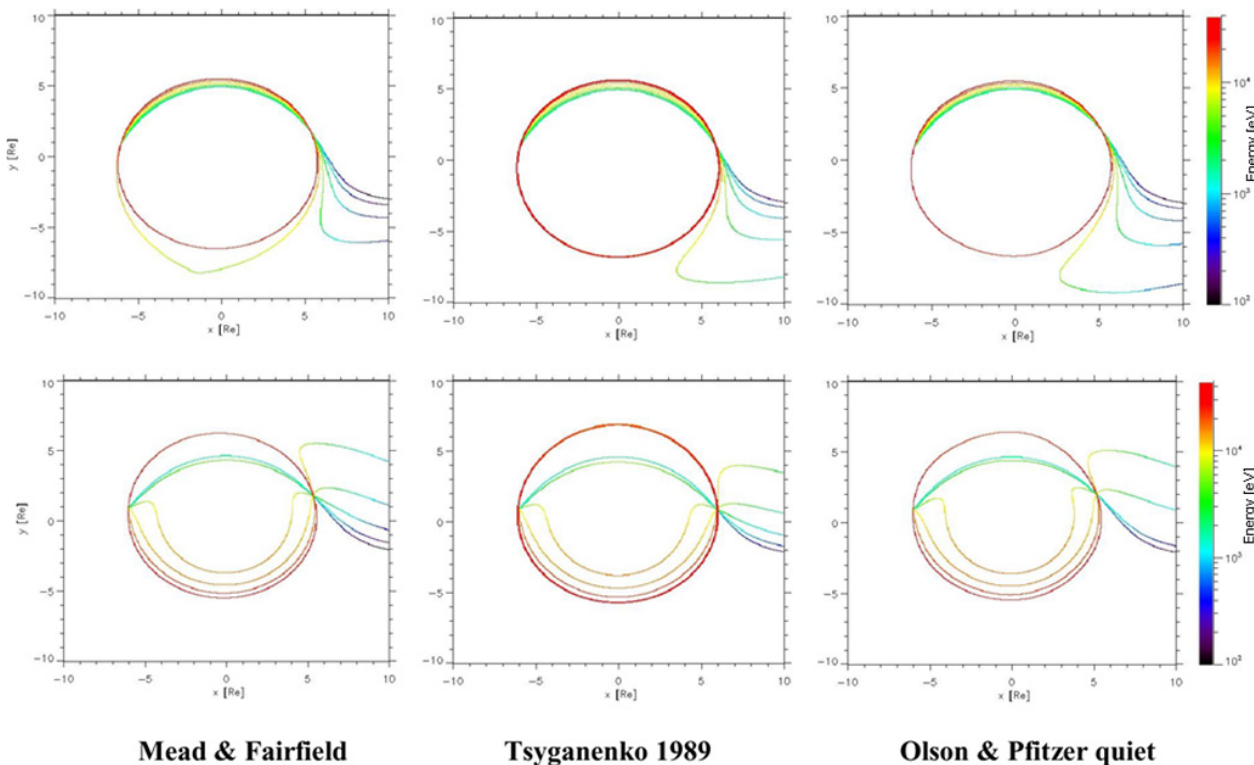
Fig. 1. Electron (top panel) and proton (bottom panel) trajectories back-in-time from the point ( − 6,1) in the equatorial plane with Mead and Fairfield, Tsyganenko (1989), and Olson and Pfitzer quiet models at Kp =